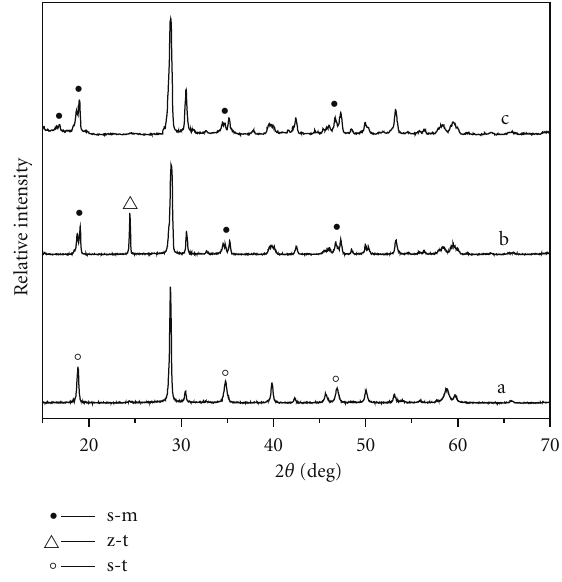
Figure 1: XRD patterns of samples at di ff erent temperature. (a): 25 ◦ C, (b): 80 ◦ C, (c): 110 ◦